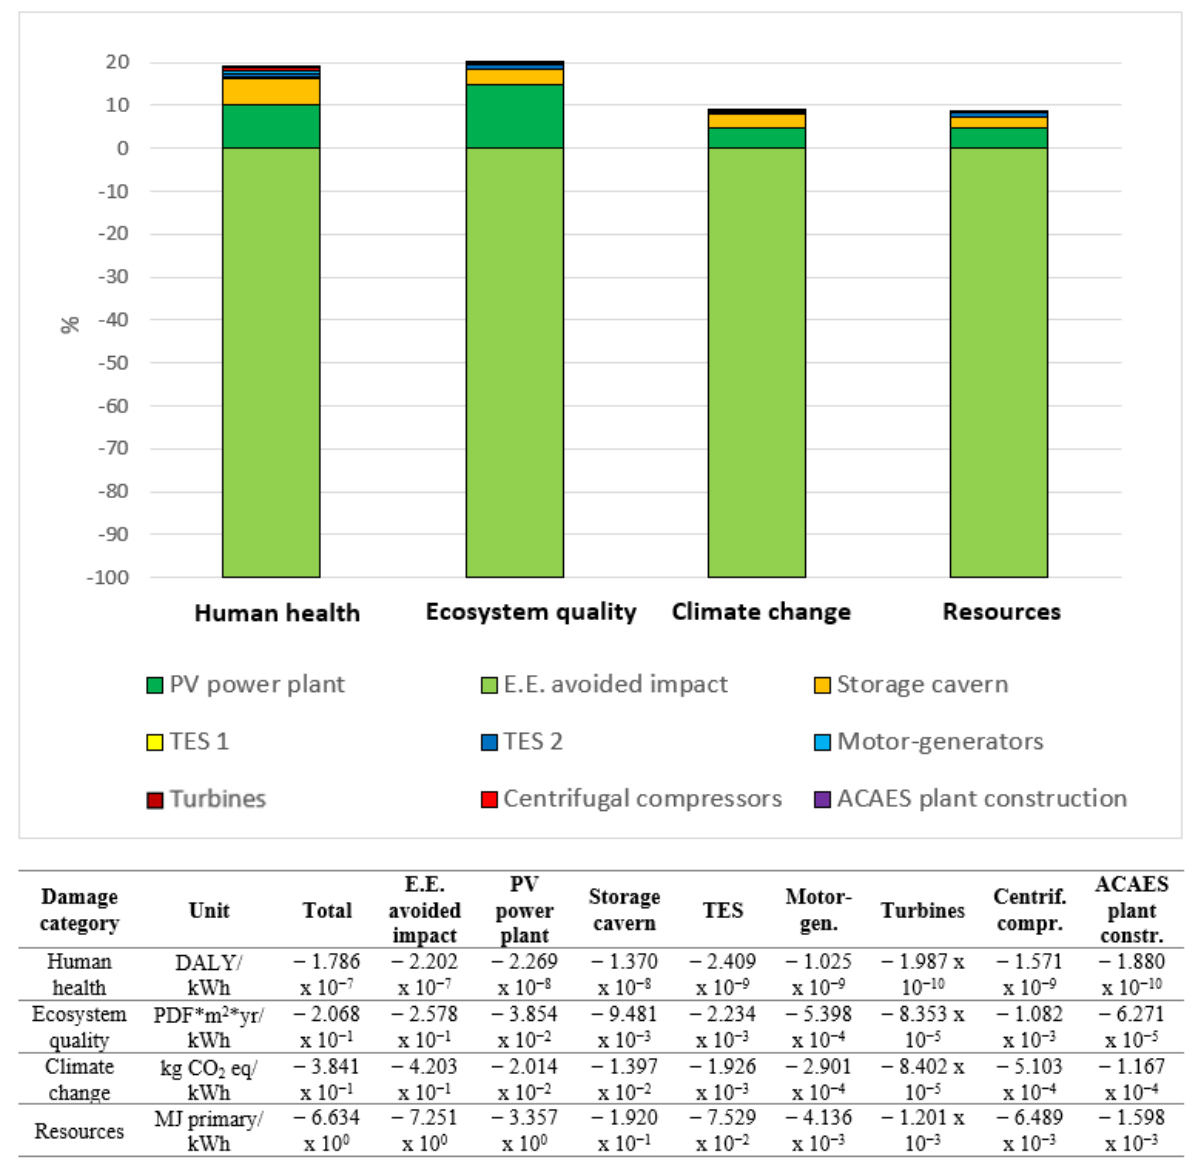
Figure 8. Impact categories for the main components of the PV-ACAES plant with underground air storage, for configuration C3.